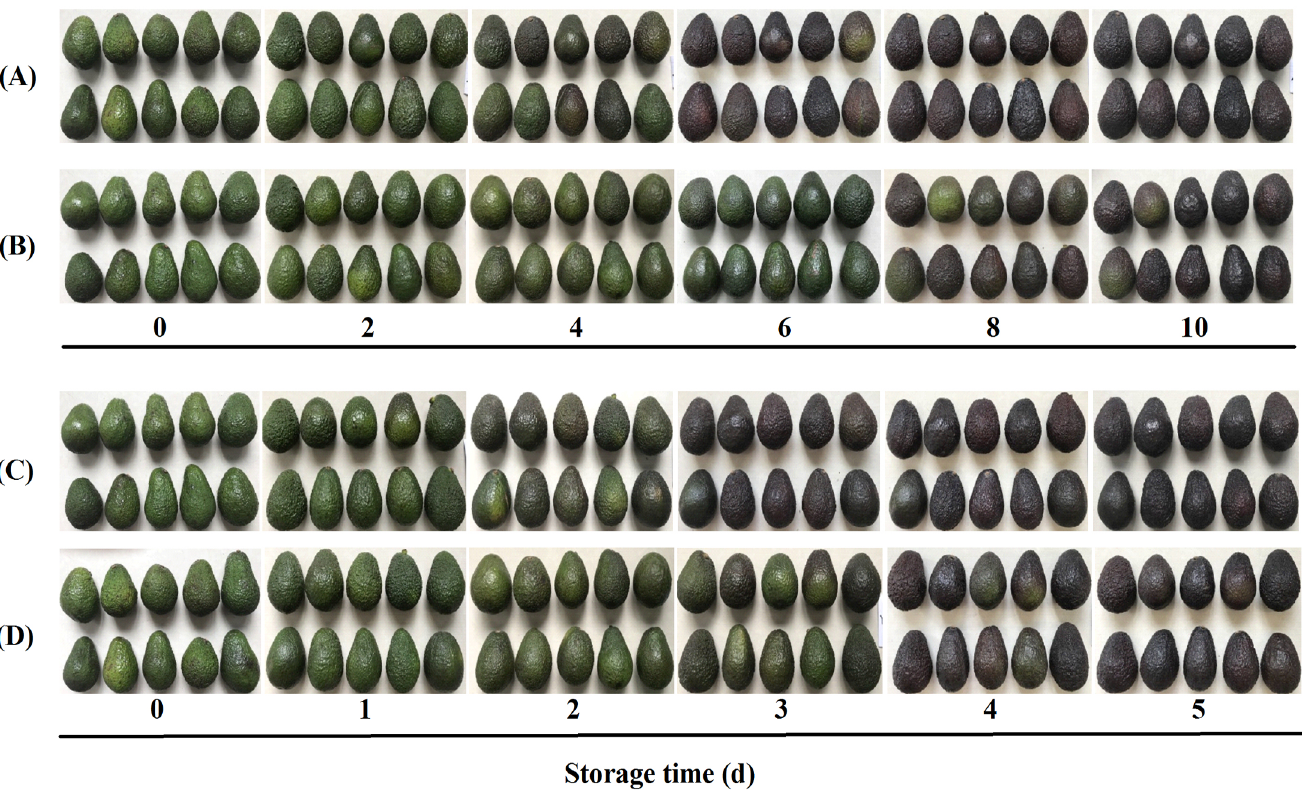
Fig 2. Visual appearanceof the avocado fruits. Natural ripeningwithout cold shock treatment (CST) (A); Natural ripeningfollowingCST (B); Exogenous ethylene-inducedripeningwithout CST (C); and Exogenous ethylene-inducedripeningfollowingCST (D).